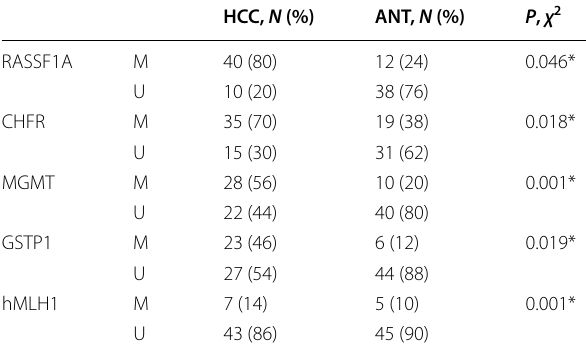
Table 2 Frequency of promoter methylation in HCC and ANT n 50 =